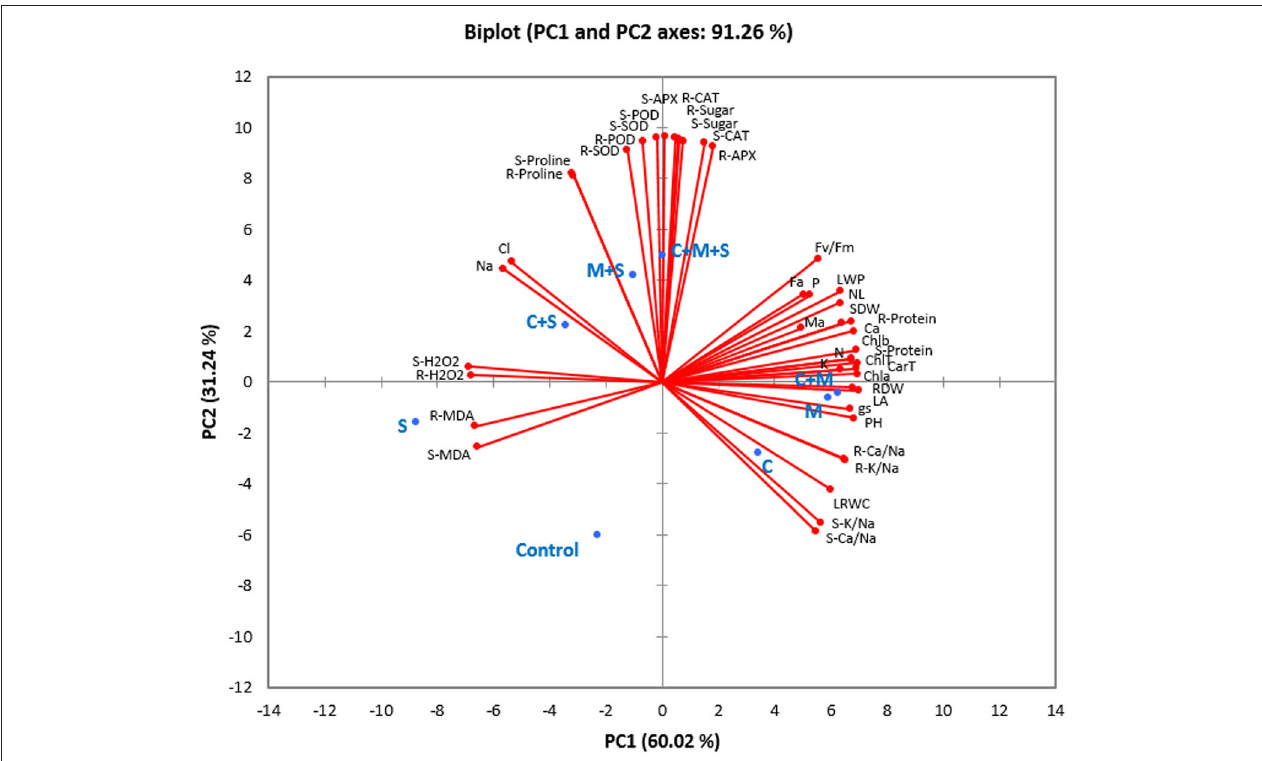
FIGURE 4 | Principal component analysis of the studied traits of different biofertilizer treatments in date palm plants growing under saline and non-saline conditions. S, Salinity; M, arbuscular mycorrhizal fungi; C, compost; PH, plant height; NL, number of leaves; LA, leaf area; SDW, shoot dry weight; RDW, root dry weight; Fa, AMF infection frequency; Ma, AMF infection intensity; Na, sodium uptake; Cl, chloride uptake; P, phosphorous uptake; N, nitrogen uptake; K, potassium uptake; Ca, calcium uptake; LRWC, leaf relative water content; LWP, leaf water potential; g s , stomatal conductance; F v /F m , photosynthetic efficiency. Chl a , chlorophyll a ; Chl b , chlorophyll b ; Chl T, total chlorophyll; Car T, carotenoids; S-K/Na, shoot K/Na ratio; R-K/Na, root K/Na ratio; S-Ca/Na, shoot Ca/Na ratio; R-Ca/Na, root Ca/Na ratio; S-H 2 O 2 , shoot H 2 O 2 content; R-H 2 O 2 , root H 2 O 2 content S-MDA, shoot MDA content; R-MDA, root MDA content; S-Proline, shoot proline content; R-Proline, root proline content; S-Sugar, shoot sugar content; R-Sugar, root sugar content; S-APX, shoot ascorbate peroxidase activity; R-APX, root ascorbate peroxidase